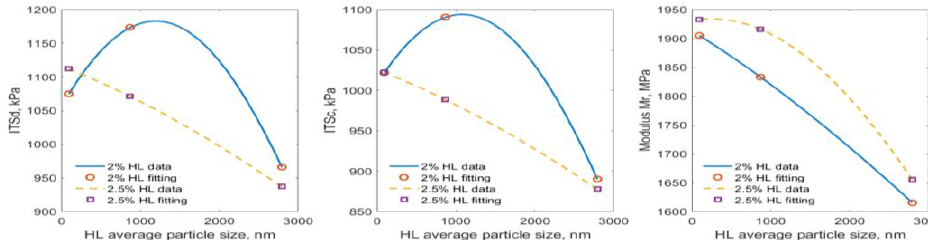
Figure 20. Gaussian characterization of tensile strength and resilient modulus at 2.0 and 2.5% HL. Table 6. The fitting data of the Gaussian formula.